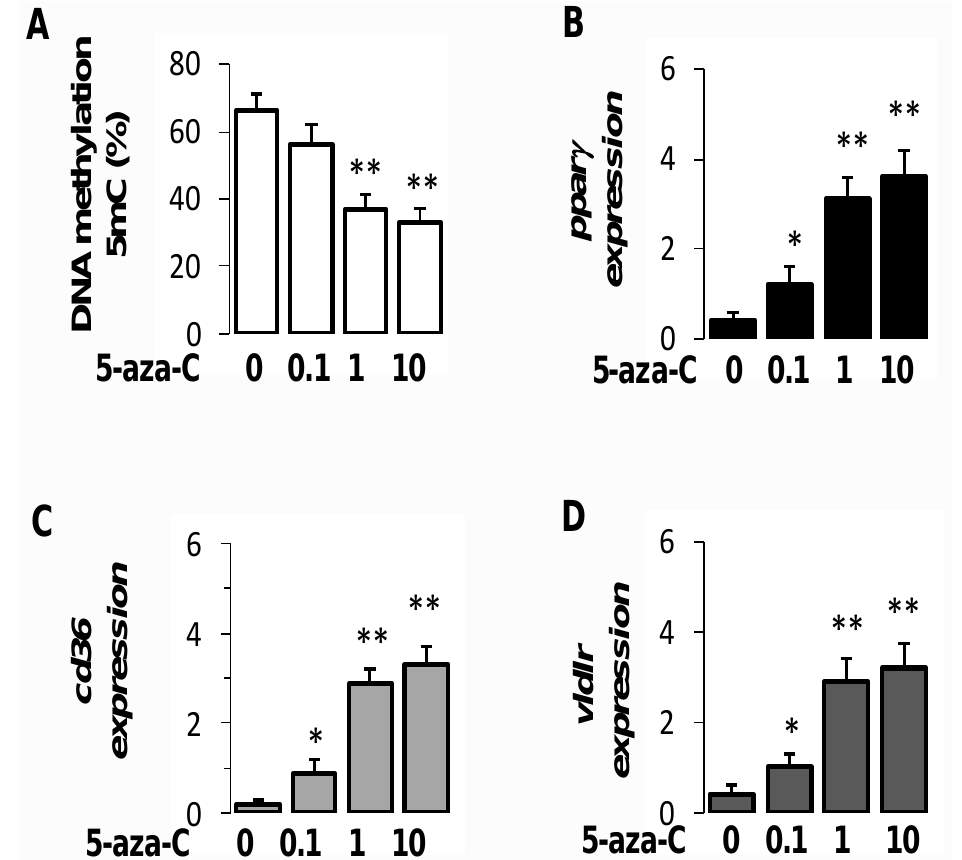
Figure 6. Inhibition of DNA methylation altered the expression of pparγ and its target genes. The effects of 5′-aza, 2′ deoxycytidine (5-aza-C) on global DNA methylation ( A ), and expression of pparγ ( B ), cd36 ( C ), and vldlr ( D ) in hepatocytes treated with 5-aza-C. Primary hepatocytes were incubated in medium without 5-aza-C (control) or with increasing concentrations of 5-aza-C for 48 h. Expression of selected genes was assessed with qPCR, as described in Methods. Experiments were conducted in duplicate, and results were generated from three experiments. Results are pre- sented as mean ± SEM ( n = 12 per experimental condition). Significance was assessed with ANOVA test followed with Tukey’s test. Significance compared to control (without 5-aza-C) is indicated with an asterisk with * p < 0.01 and ** p < 0.001.